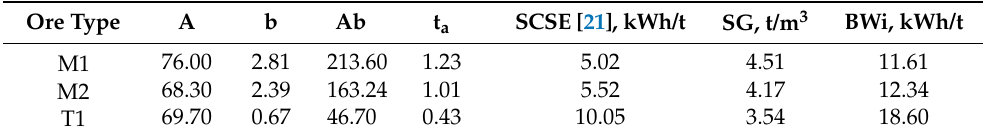
Table 1. Strength characteristics of ore types.